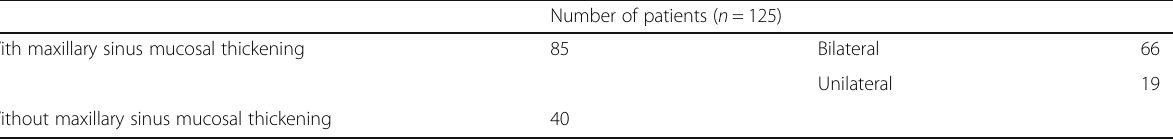
Table 2 With/without maxillary sinus mucosal thickening on MDCT images 1 month after surgery